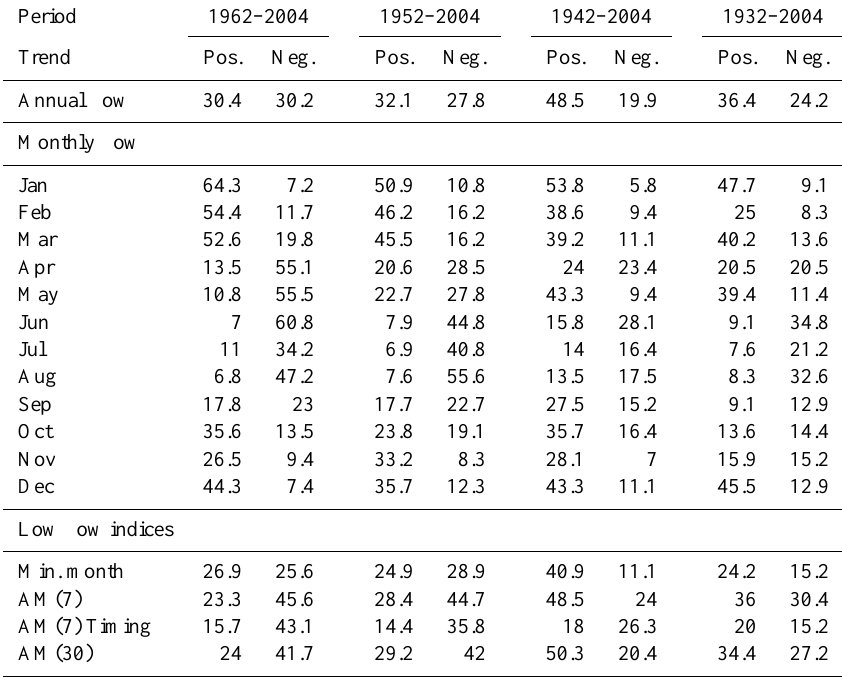
Table 2. Percentage of positive and negative trends.* Period Trend Pos. Neg. Pos.